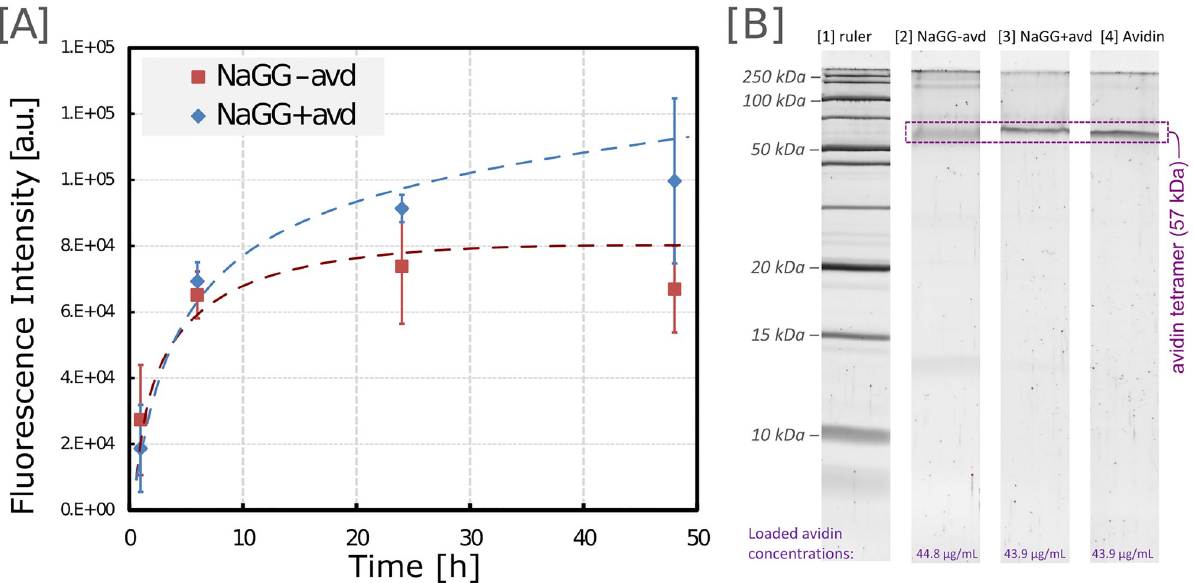
Fig 3. Avidin-GG coupling analysis. (A) Elution analysis: Fluorescence intensity of supernatants of hydrogel samples immersed in PBS. Supernatant was collected from separate samples over 2 days and analyzed with fluorescence spectrometer. Error bars represent standard deviation calculated from three independent samples, and logarithmic fit curves were added to guide the eye. (B) SDS-PAGE: Electrophoretic separation and comparison of conjugated (NaGG-avd) and unconjugated (NaGG+avd) samples. Tetrameric avidin band (57 kDa) is very faint and blurry for NaGG-avd, compared with NaGG+avd and pure avd, indicating covalent bonding between avidin and